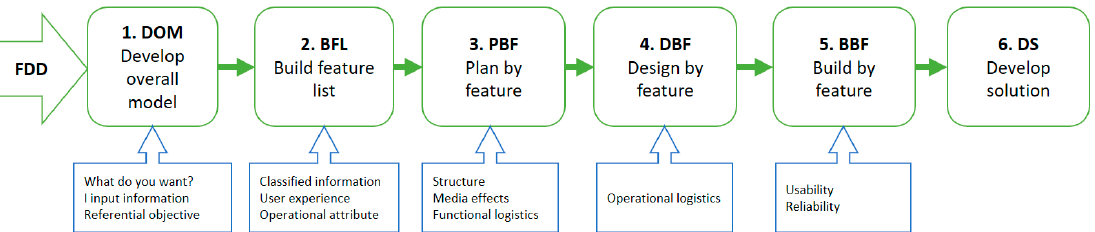
Figure 1. FDD (Feature Drive Development) procedural structure.